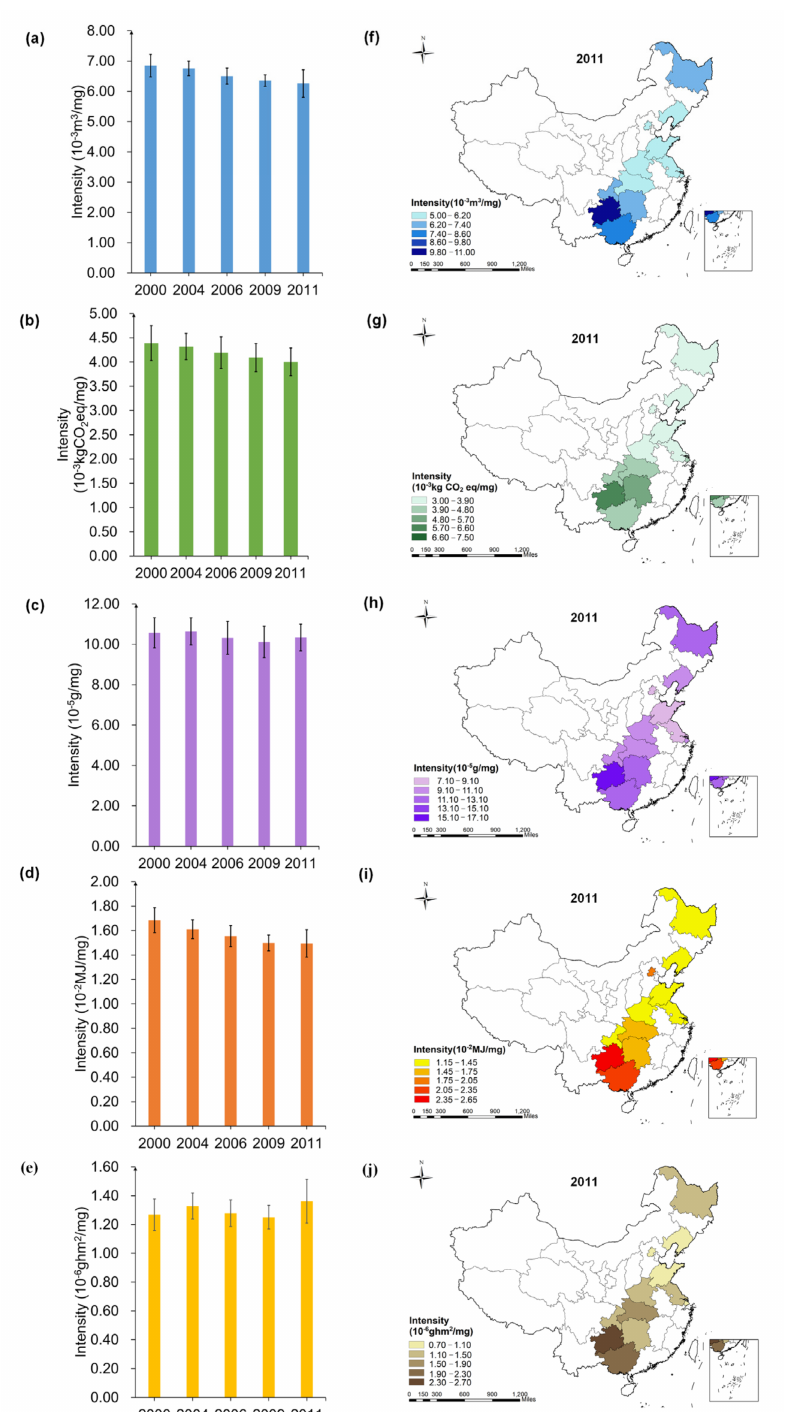
Figure 7. Spatial-temporal characteristics of multiple footprint intensity of cholesterol intake ( a , f ): WF; ( b , g ): CF; ( c , h ): NF; ( d , i ): EF; ( e , j ): LF; The error lines in the figure are standard